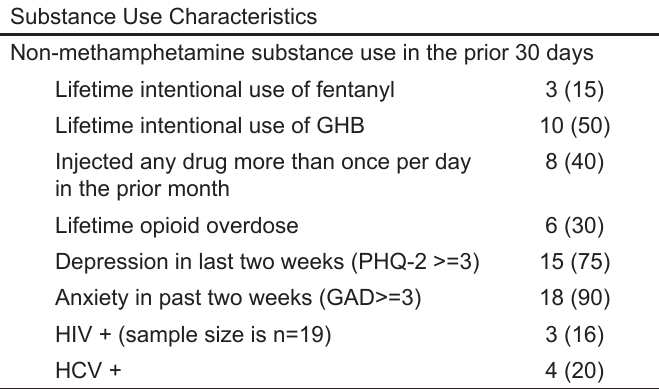
characteristics, and medical characteristics of interviewees.